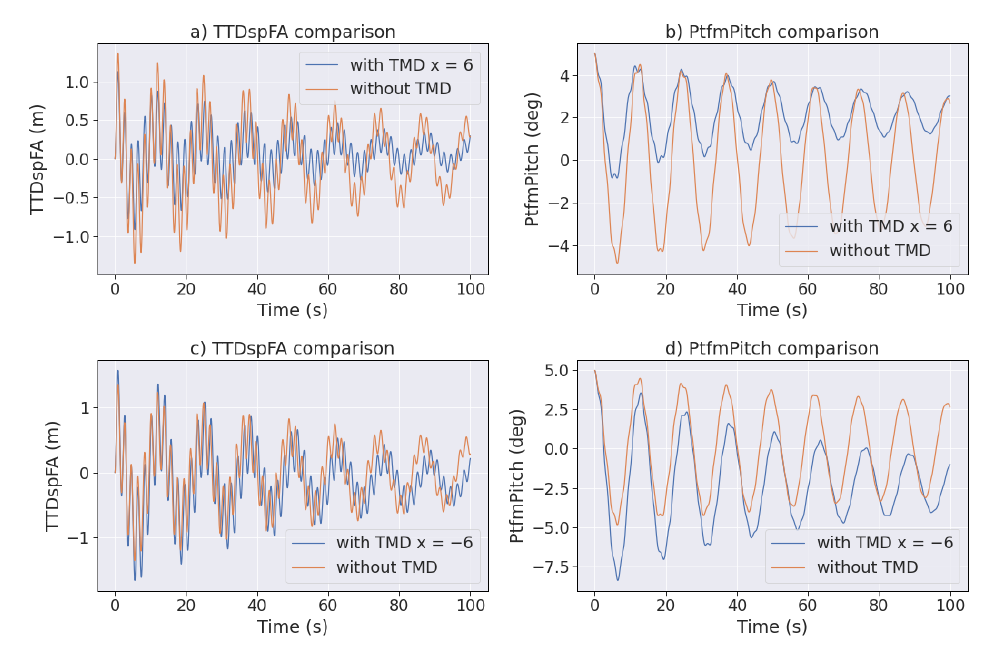
Figure 7. Comparison of the PtfmPitch ( a ) and TTDspFA ( b ) without TMD (orange) and with TMD located at 6 m ( a ) and ( b ) and –6 m ( c ) and ( d ) in the fore–aft direction